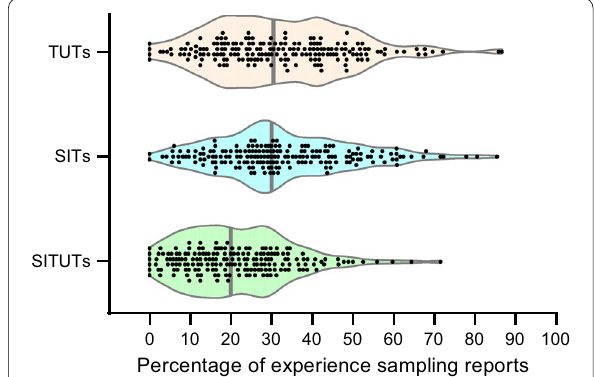
Fig. 1 Violin plot showing the distributions of task‑unrelated thoughts (TUTs), stimulus‑independent thoughts (SITs) and stimulus‑independent and task‑unrelated thoughts (SITUTs) across individuals ( N 187). Vertical grey lines denote =